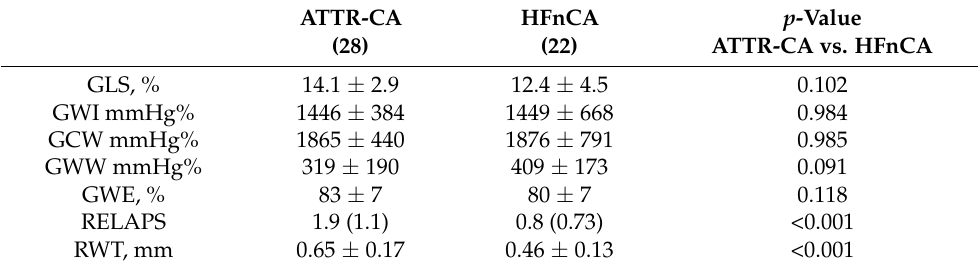
Table 3. Echocardiographic data in ATTR-CA and HFnCA in patients with sinus rythm.